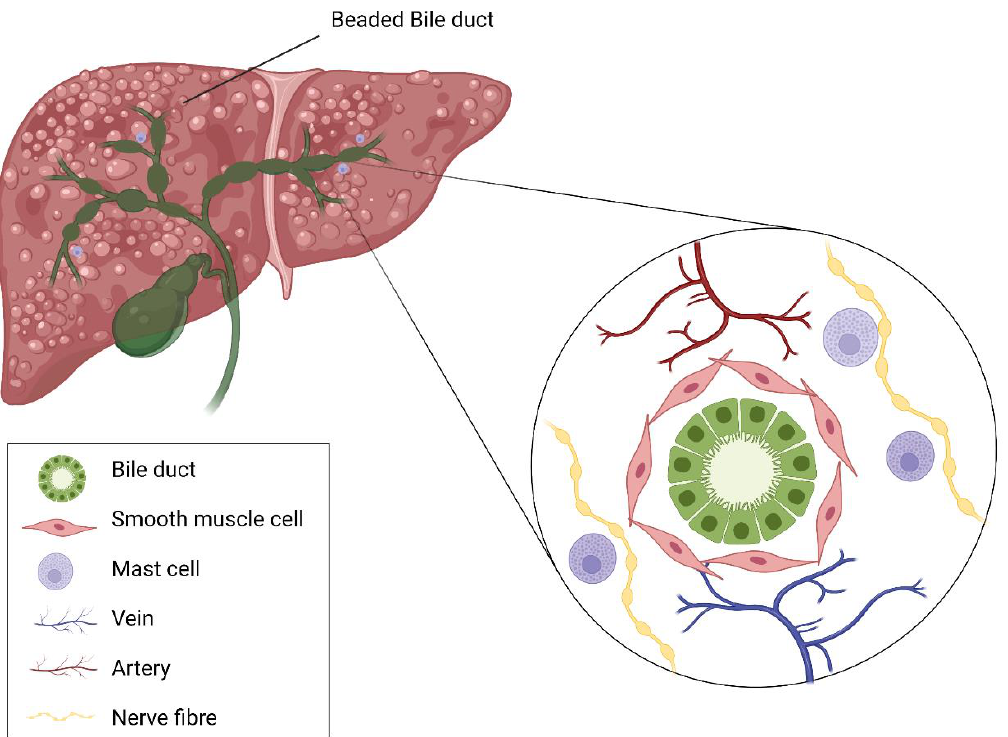
Figure 1. The location of mast cells within an inflamed liver. PSC/PBC livers share the pathological feature of extensive fibrosis. Beading of intra- and extra-hepatic bile ducts is a common feature in PSC and is due to collagen fibre deposition around the bile ducts, leading to compression. MCs have been observed to infiltrate areas of fibrosis and damaged bile ducts. Generally, MCs tend to associate with connective tissues found near hepatic arteries, veins, and bile ducts of the portal tracts. MCs reside close to vascular smooth muscle cells and may be involved in the regulation of the peribiliary vascular plexus along the intrahepatic biliary tree and in proximity to the nerve fibres around portal tracts. MC liver infiltration is significantly increased in immune-mediated cholangiopathies such as PSC and PBC.